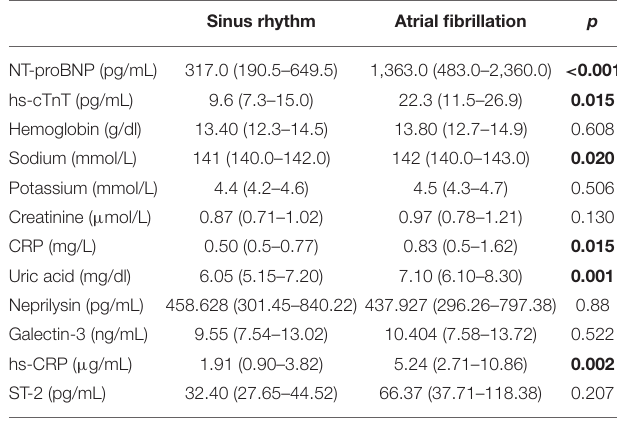
TABLE 6 | Analysis of laboratory tests and biomarkers results in AF and non-AF groups. Sinus rhythm Atrial